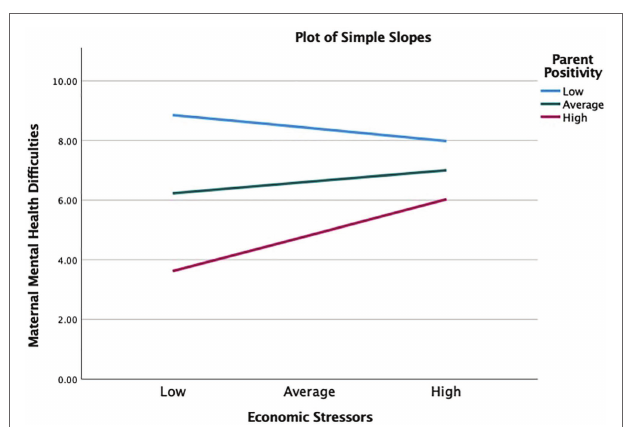
FIGURE 2 | Parent positivity moderating the effect of economic stressors on maternal mental health. High = 1 standard deviation above the sample mean, average = sample mean, and low = 1 standard deviation below the sample